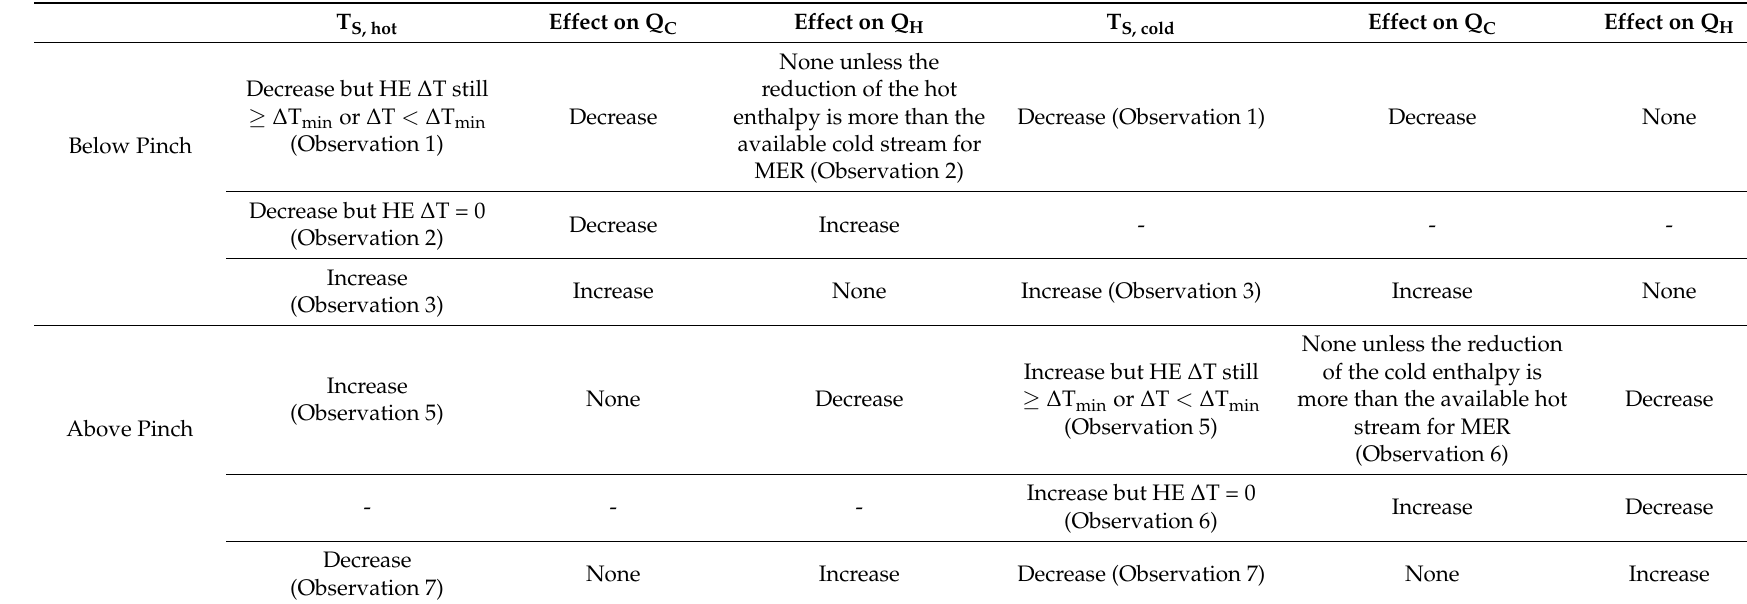
Table 2. Summary of cold and hot stream supply temperature disturbances on hot and cold